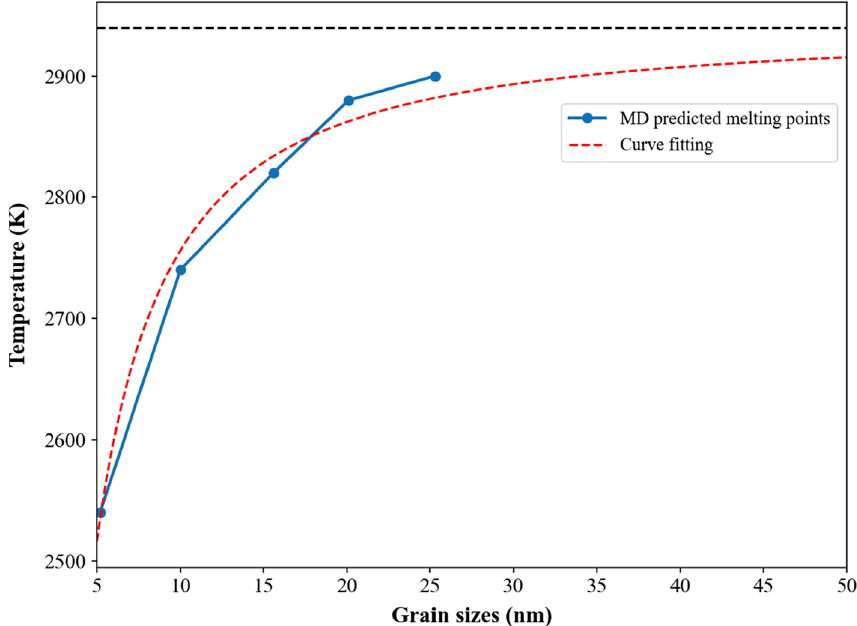
Figure 5. Profile of MD predicted melting points for polycrystalline Nb 20.6 Mo 21.7 Ta 15.6 W 21.1 V 21.0 RHEAs with the average grain sizes from 5.2 to 25.3 nm. The curve fitting profile using Eq. (2) is also provided. The horizontal dashed line stands for the melting point (2940 K) of the single crystal Nb 20.6 Mo 21.7 Ta 15.6 W 21.1 V 21.0